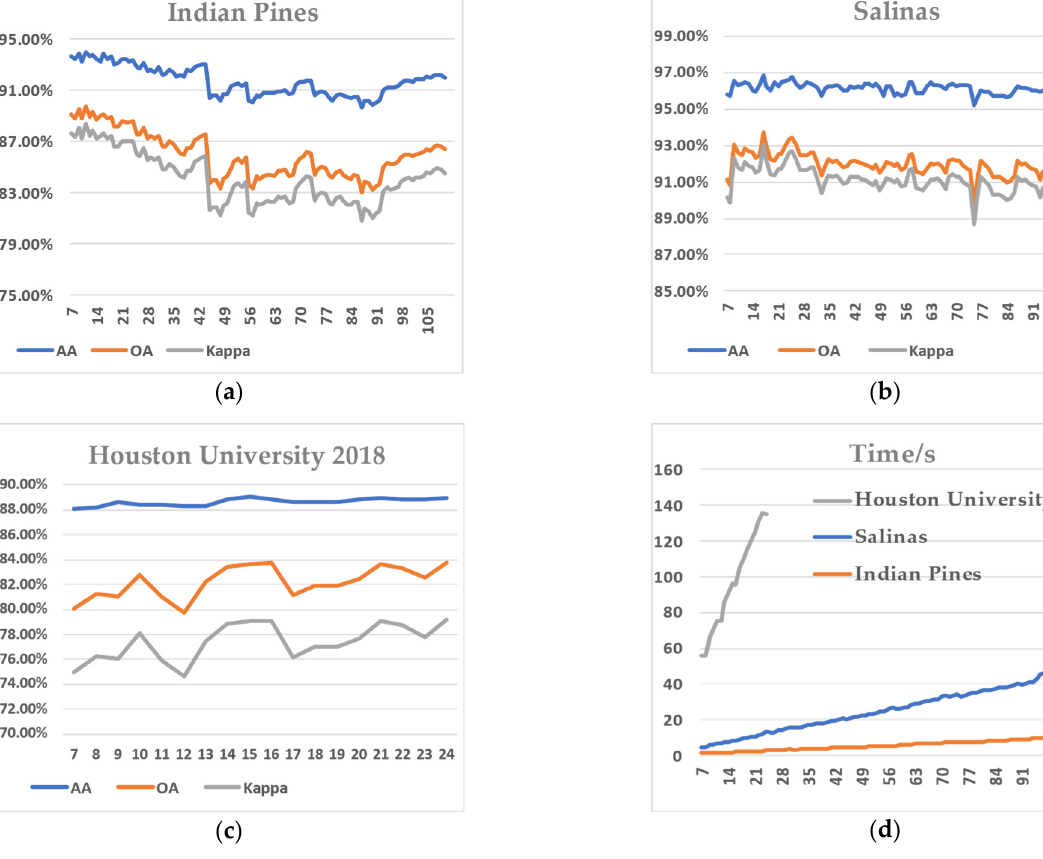
Figure 5. Effect of using different n in three datasets. ( a ) Indian Pines, with n growing from 7 to 110; ( b ) Salinas, with n growing from 7 to 112; ( c ) Houston University 2018, with n growing from 7 to 24. ( d ) Computing time in corresponding datasets.